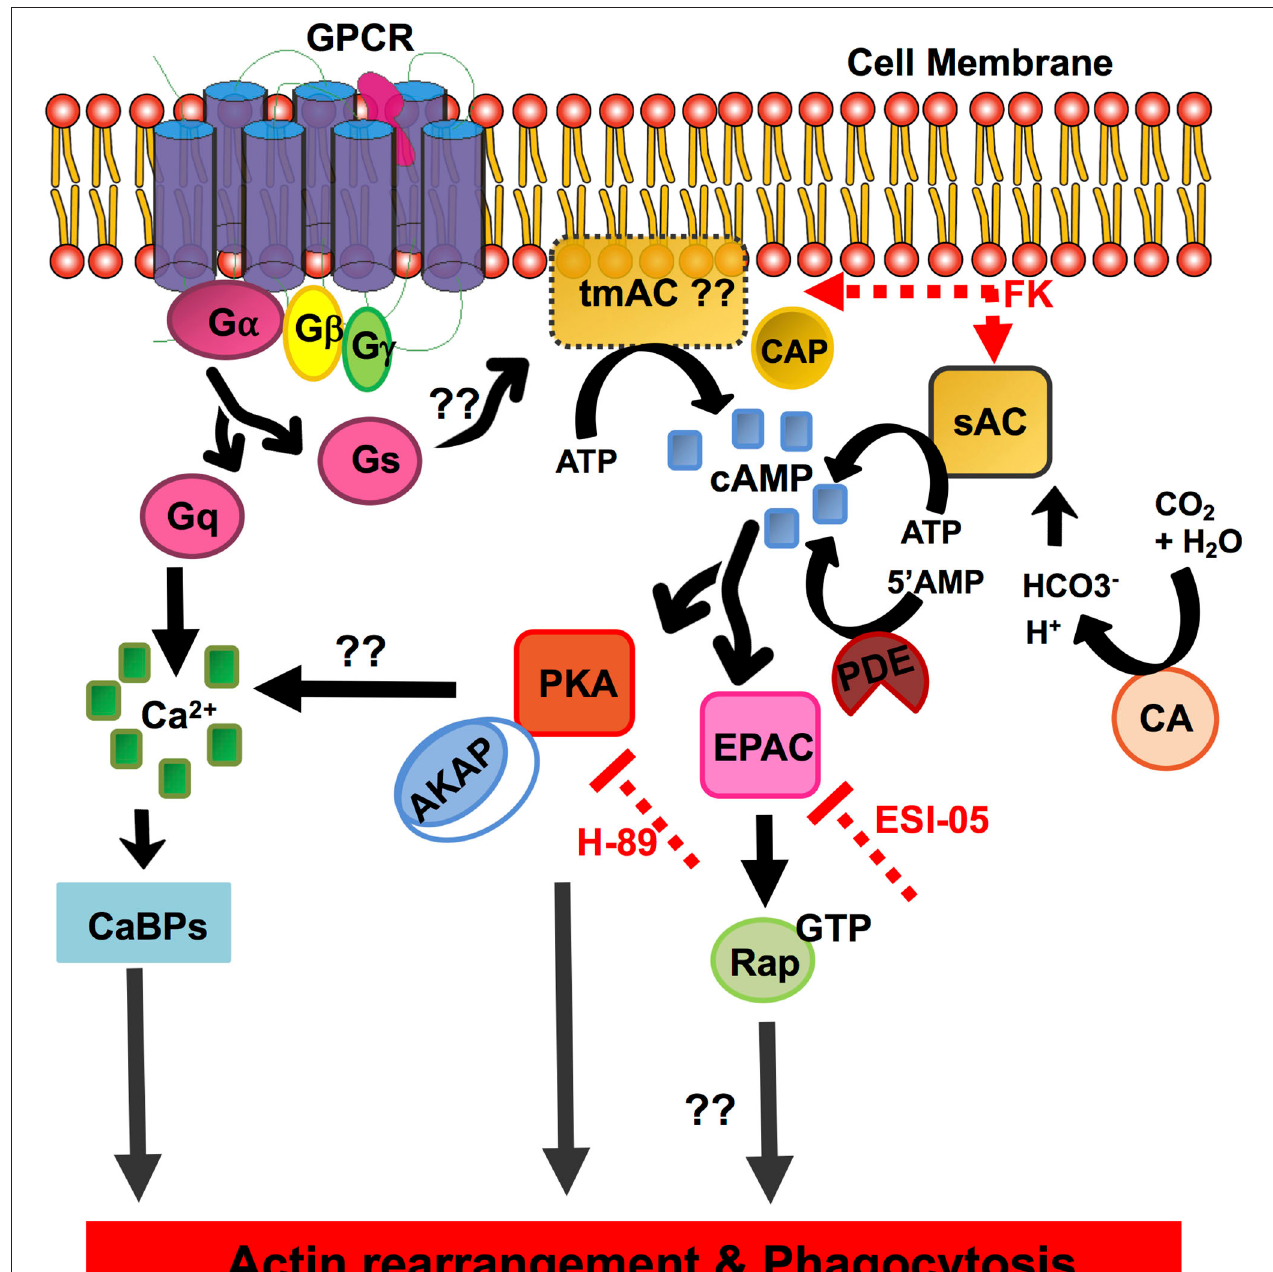
FIGURE 4 | Schematic overview of the elements of the cAMP signal transduction pathway identified in E. histolytica . The diagram depicts the pathway components involving cAMP activation, formation/degradation, and downstream effector proteins important for cAMP signaling. GPCR, G-protein-coupled receptors; heterotrimeric G-proteins, G α , G β , and G γ subunits; Gs, stimulatory G-protein; Gq, G-protein subunit that activates phospholipase C; tmAC, transmembrane adenylate cyclase; sAC, soluble adenylate cyclase; cAMP, cyclic AMP; CAP, adenylate cyclase-associated protein; CA, carbonic anhydrase; FK, forskolin; PDE, phosphodiesterase; PKA, protein kinase A; EPAC, exchange protein activated by cAMP; AKAP, A-kinase anchoring proteins; Rap-GTP, GTP-binding Ras-related protein; H-89, inhibitor of PKA; ESI-09, inhibitor of EPAC; CaBPs, calcium-binding